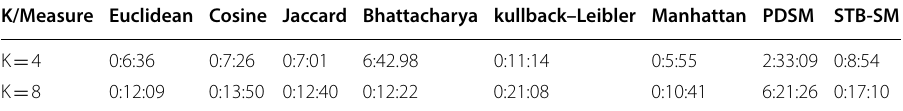
Table 22 Web‑KB – Run Time in (Hour: Minute: Second) K/Measure Euclidean Cosine Jaccard Bhattacharya kullback–Leibler Manhattan PDSM STB‑SM K =